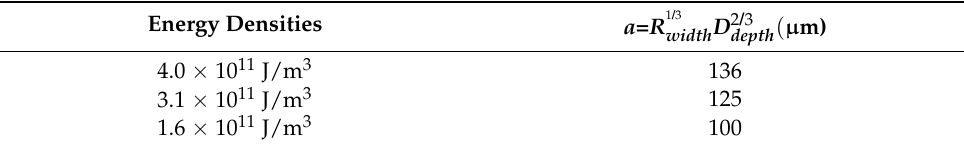
Table 3. The droplet size depends on the simulation